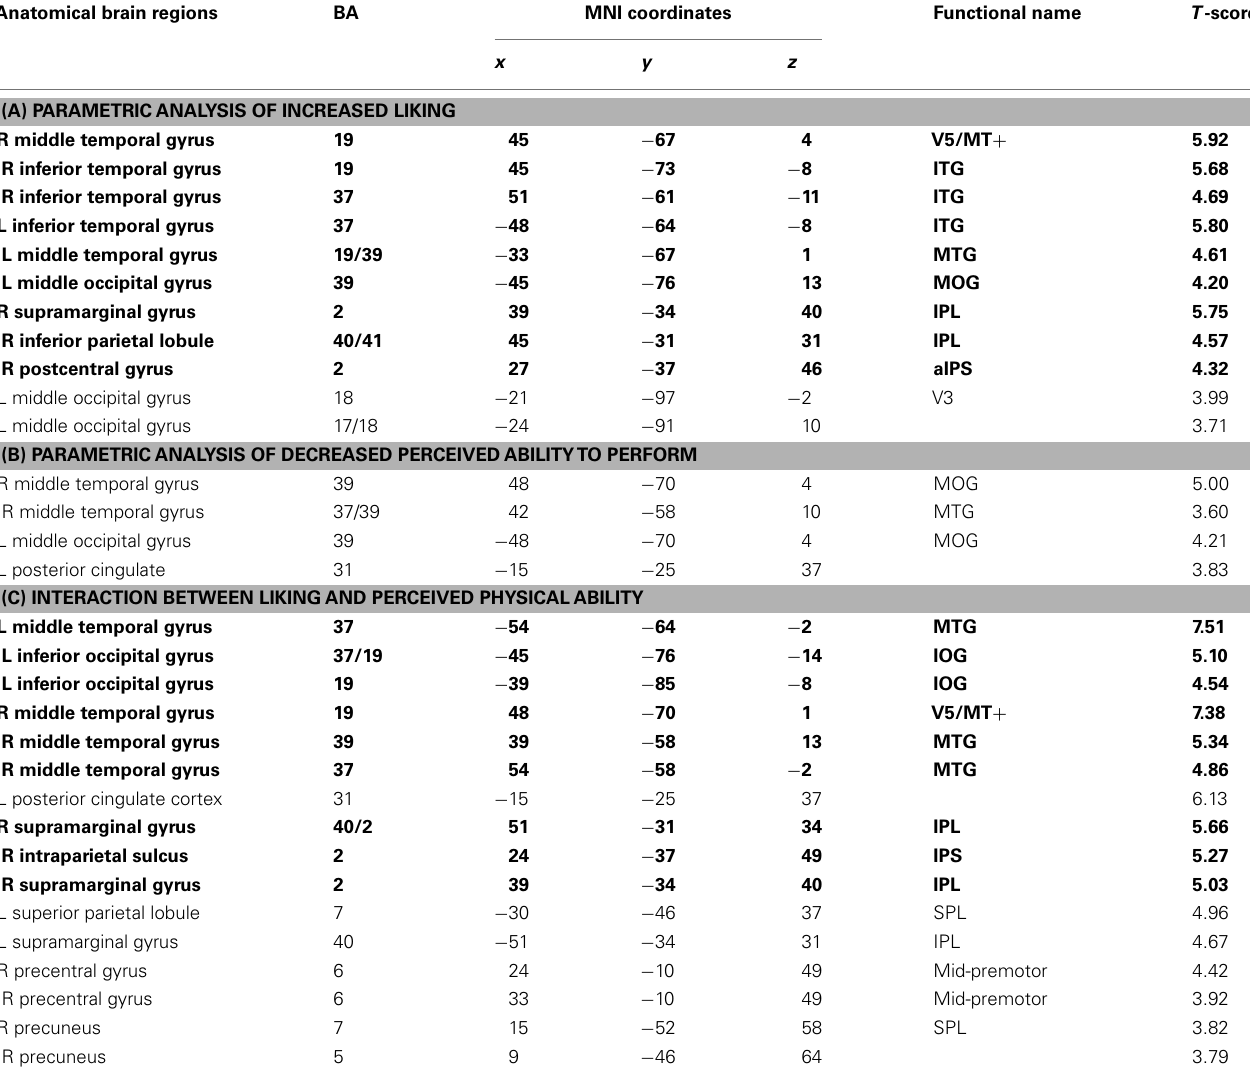
Table 2 | Parametric effects of and interaction between liking and physical